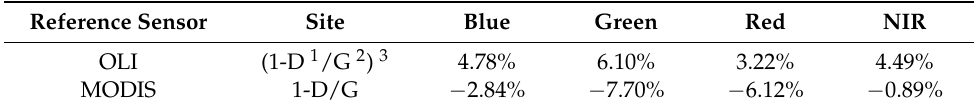
Table 6. The relative error of cross-calibration coefficients between Dunhuang and Golmud sites using Landsat 8 OLI and MODIS sensor as a